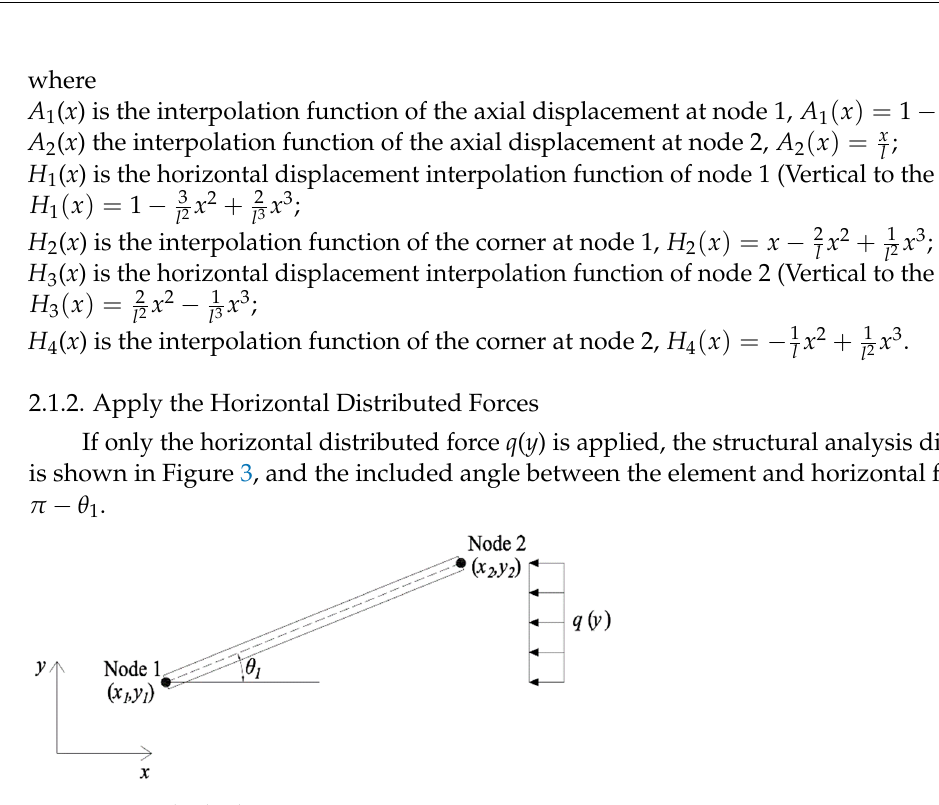
Figure 3. Free body